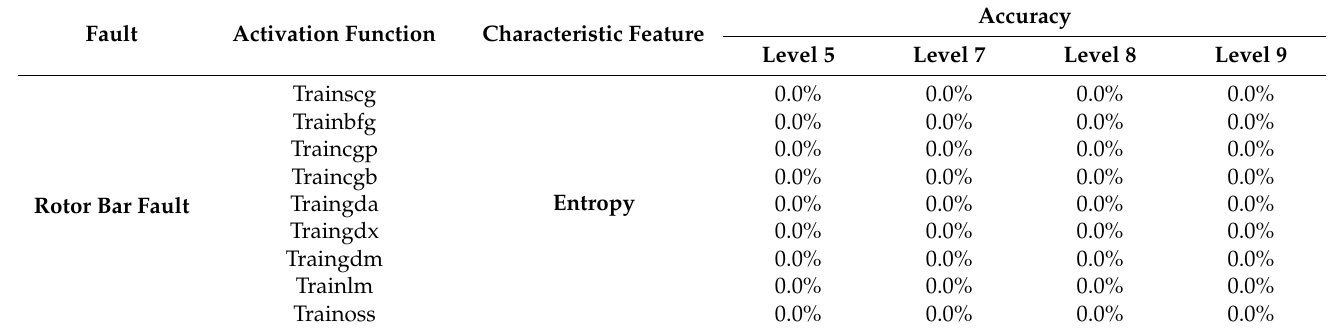
Table 7. Rotor Bar Fault with Entropy Features Accuracies with different Activation